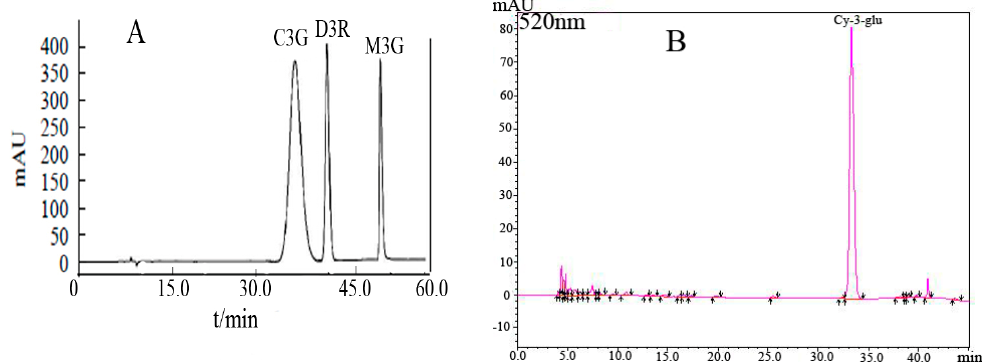
Figure 1 . ( A ) HPLC chromatogram of anthocyanin standards; ( B ) HPLC chromatogram of Cy-3-glu in blueberries. Notes: delphinidin-3-rutinoside (D3R); cyanidin-3-glucoside (C3G); malvidin-3-galactoside (M3G).